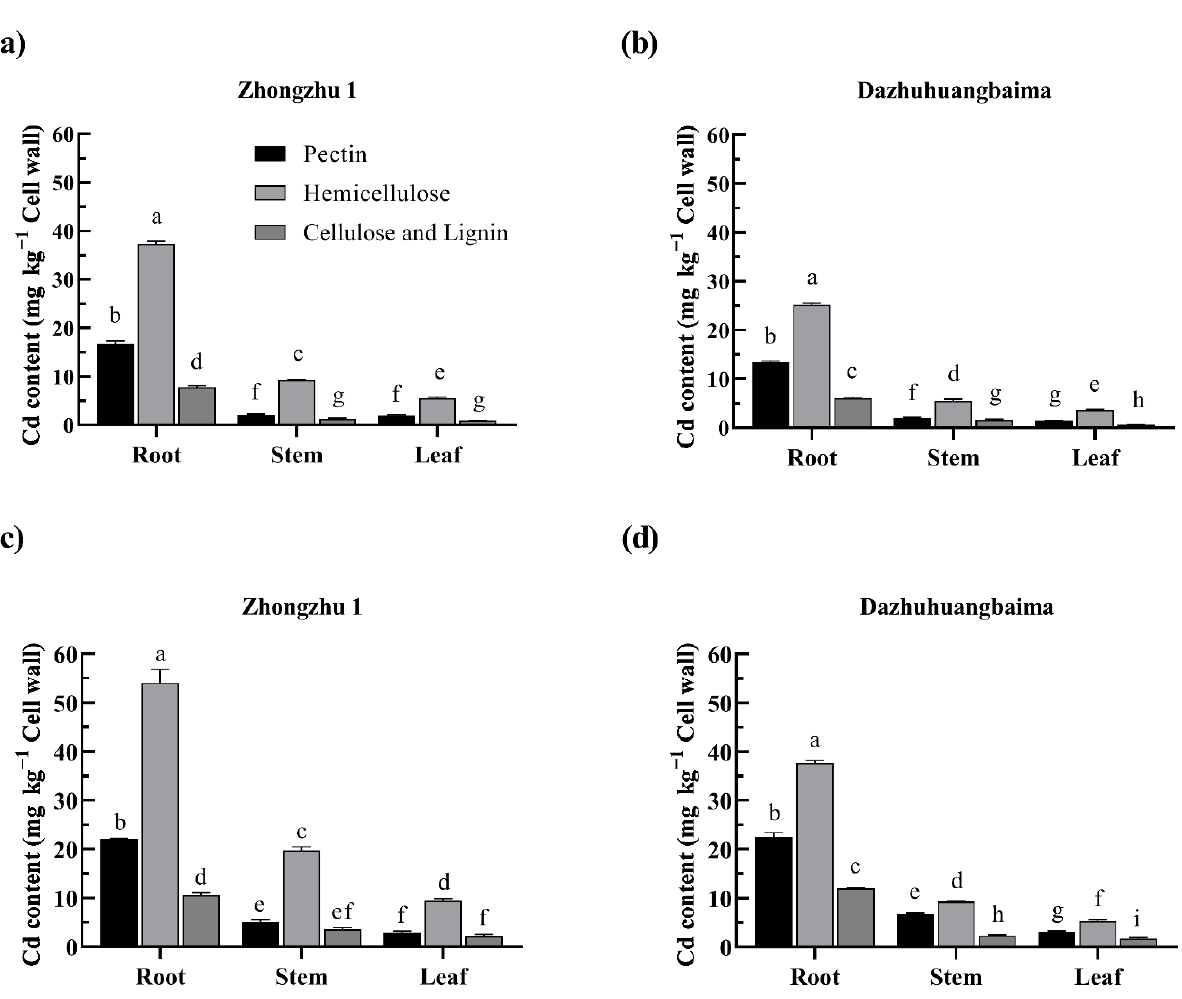
Figure 3. Cd content in the cell wall polysaccharides of two ramie populations. Cd content in the cell wall polysaccharides of ‘Zhongzhu 1’ treated with ( a ) 25 mg kg − 1 and ( c ) 75 mg kg − 1 Cd, respectively, and ‘Dazhuhuangbaima’ treated with ( b ) 25 mg kg − 1 and ( d ) 75 mg kg − 1 Cd, respectively. Data represent means ± SD ( n = 3). Different letters indicate significant differences at p ≤ 0.05.